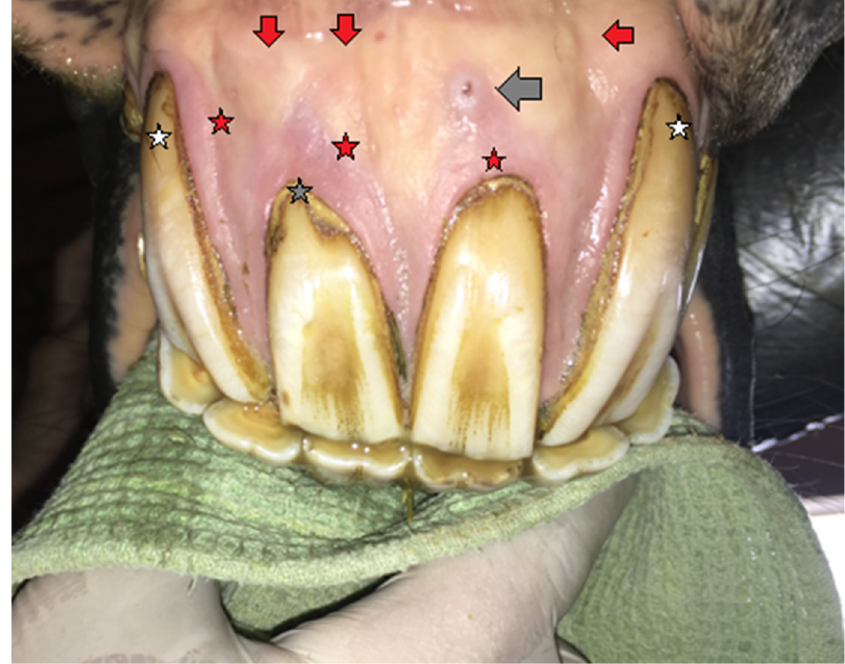
Figure 6. Case 2—the condition of the maxillary incisors before extraction. White stars—recessing gumlines, gray stars—excessive calculus deposition, red stars—gingivitis, gray arrow—fistula, red arrows—deformation of incisal processes.